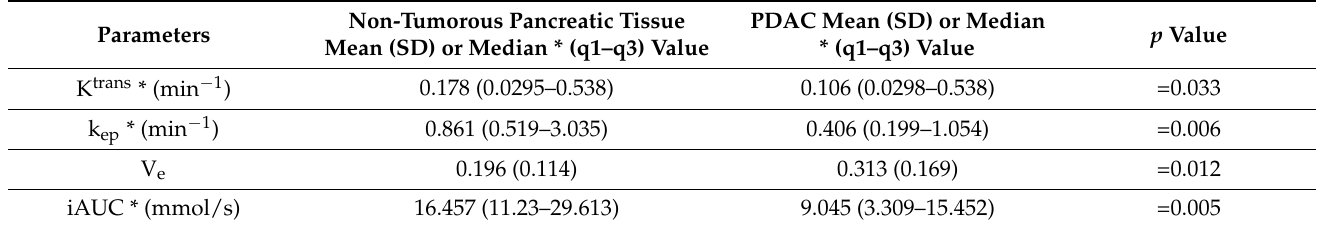
Table 2. DCE-MRI perfusion parameters in normal pancreatic parenchymal tissue and PDAC.